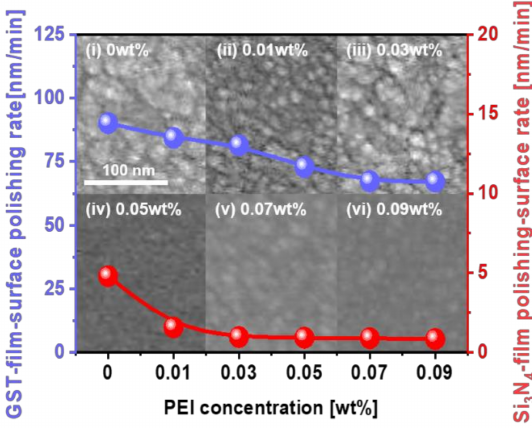
Figure 8. Dependency of Ge 1 Se 4 Te 5 -, and Si 3 N 4 films polishing-rate on corrosion inhibitor (i.e., PEI) concentration. The background SEM images examined the presence of corrosion-induced pits on the Ge 1 Sb 4 Te 5 film surface after